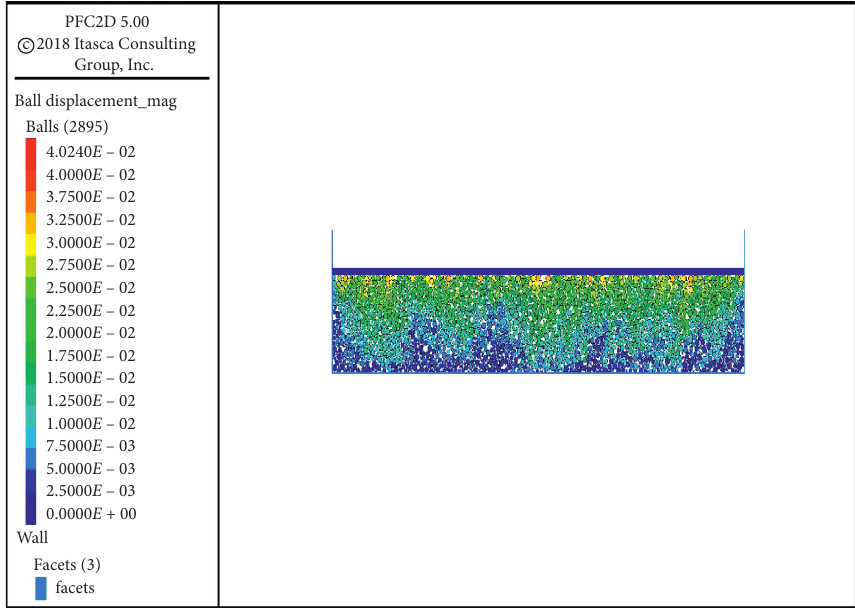
Figure 11: Discrete element particle migration map of 30 cm thick reclaimed soil with five